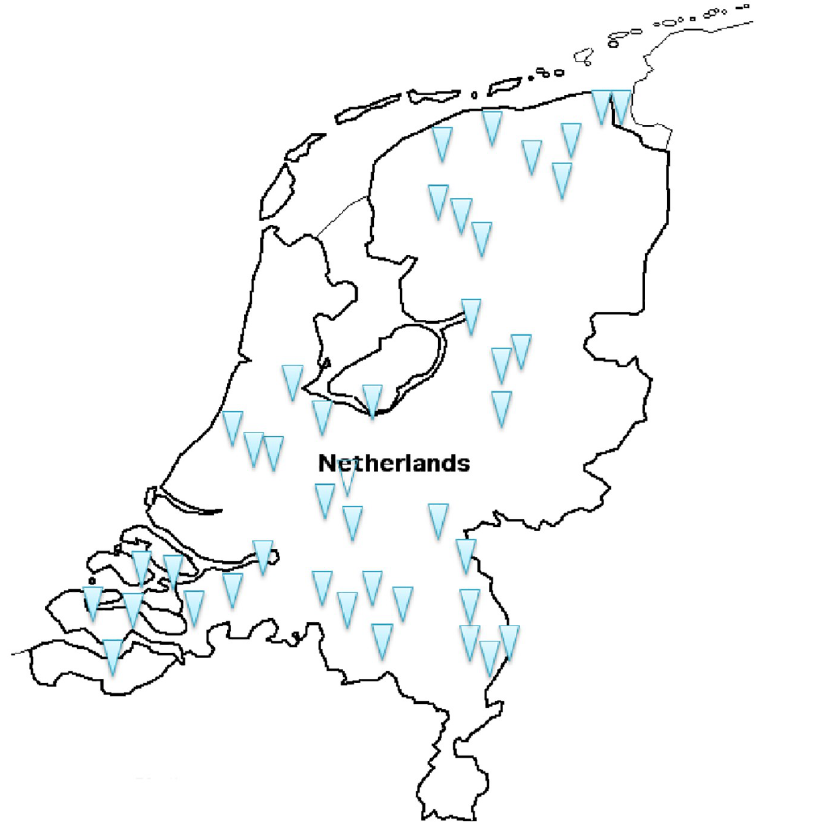
Fig 1. The location of dental practices of the participating